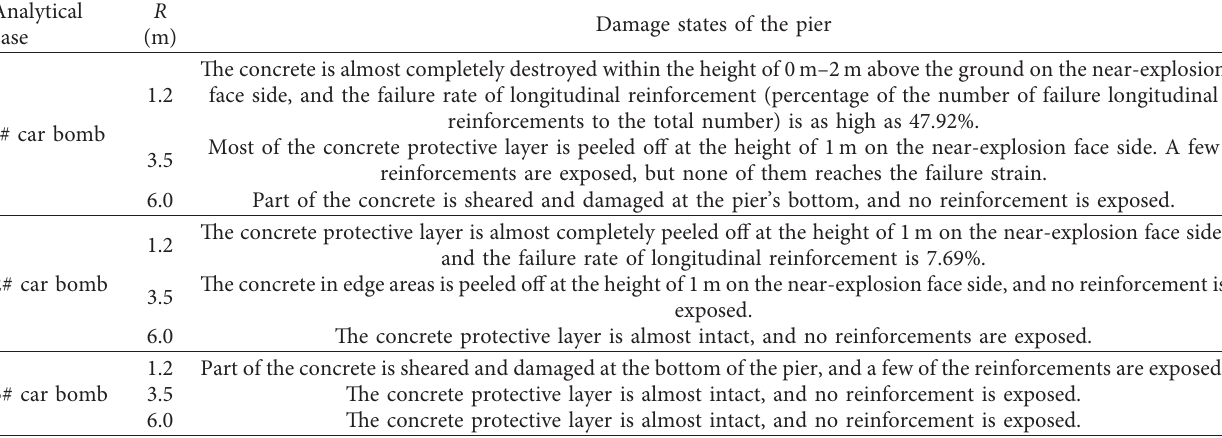
Table 3: Damage states of several analytical